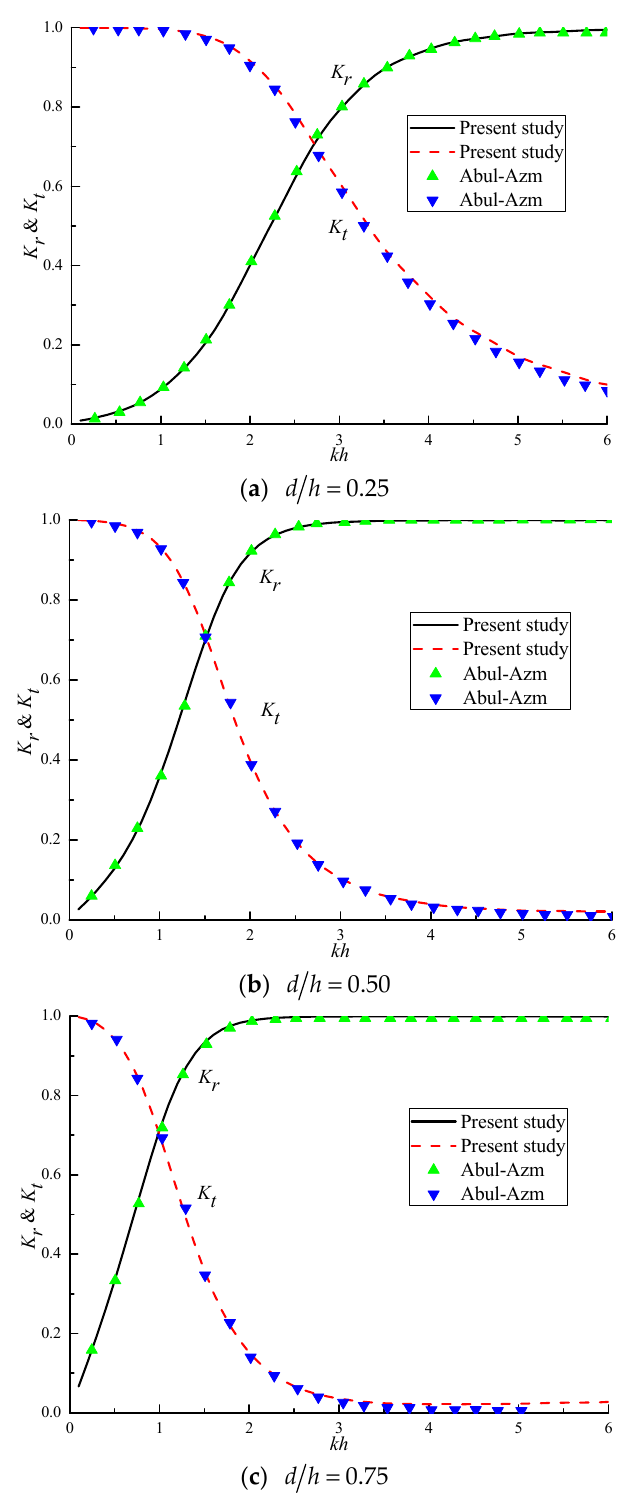
Figure 4. Comparisons of the numerical and analytical results of reflection and transmission coeffi- cients.